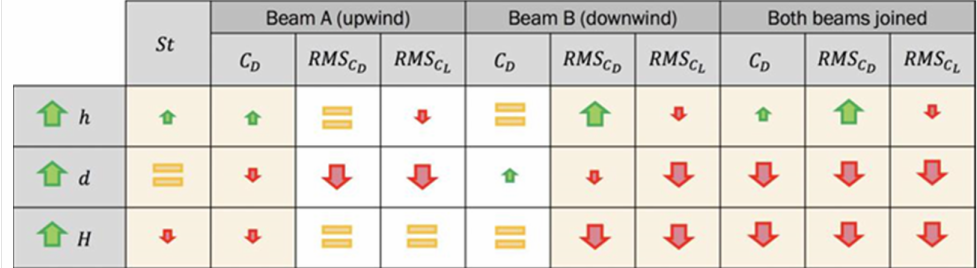
Figure 11. Influence of the variations of each geometrical parameter on the aerodynamic coefficients of the section. Small arrows represent maximum changes around 5–10%, while large arrows represent maximum changes of more than 10%. Cells with white background represent parameters with nearly zero